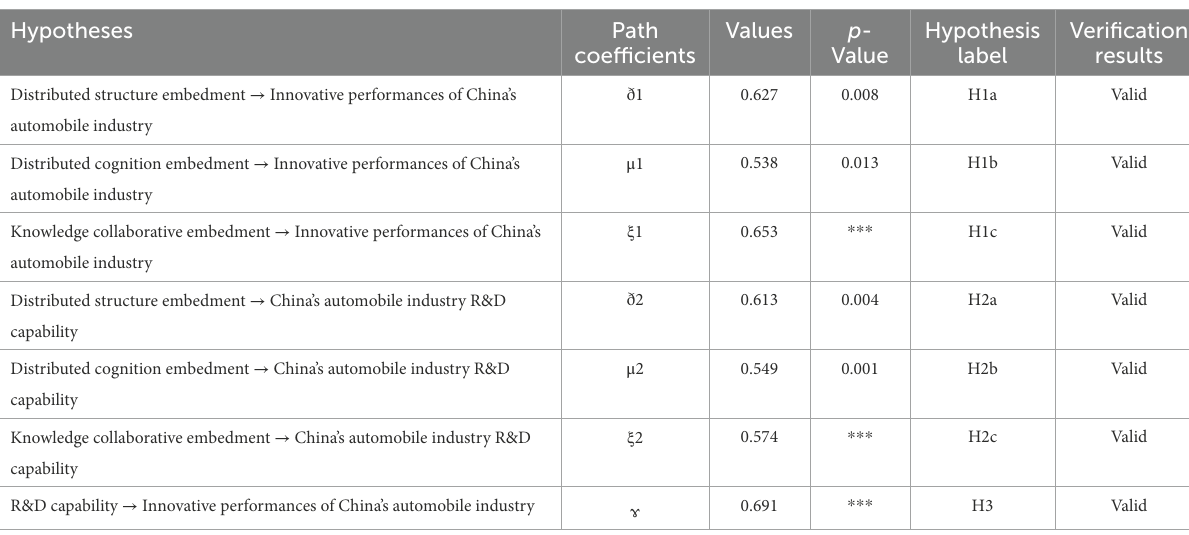
TABLE 2 Results of hypothesis